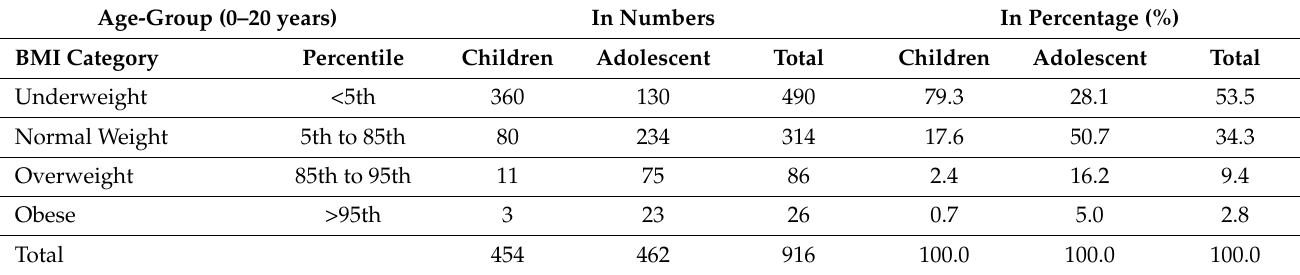
Table 3. Distribution of BMI Category/Percentile sample for children and adolescent